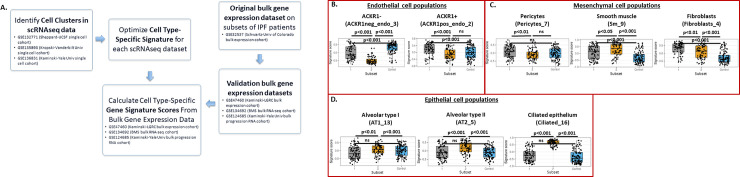
Gene signature scores for non-hematopoietic cell populations in GSE47460 (Kaminski-LGRC bulk expression cohort) [14–17] subclasses.Signatures were determined using total lung mononuclear cell data from GSE132771 (Sheppard-UCSF single cell cohort) [19]. Cell cluster names follow labeling in S3A Fig. Labels used in S3 Fig are indicated in parentheses. A. Details of our workflow with datasets used at each step indicated. B. Gene signature scores for endothelial cell subpopulations. C. Gene signature scores for mesothelial cell populations. D. Gene signature scores for epithelial cell subpopulations. Adjusted p values are reported on plots.